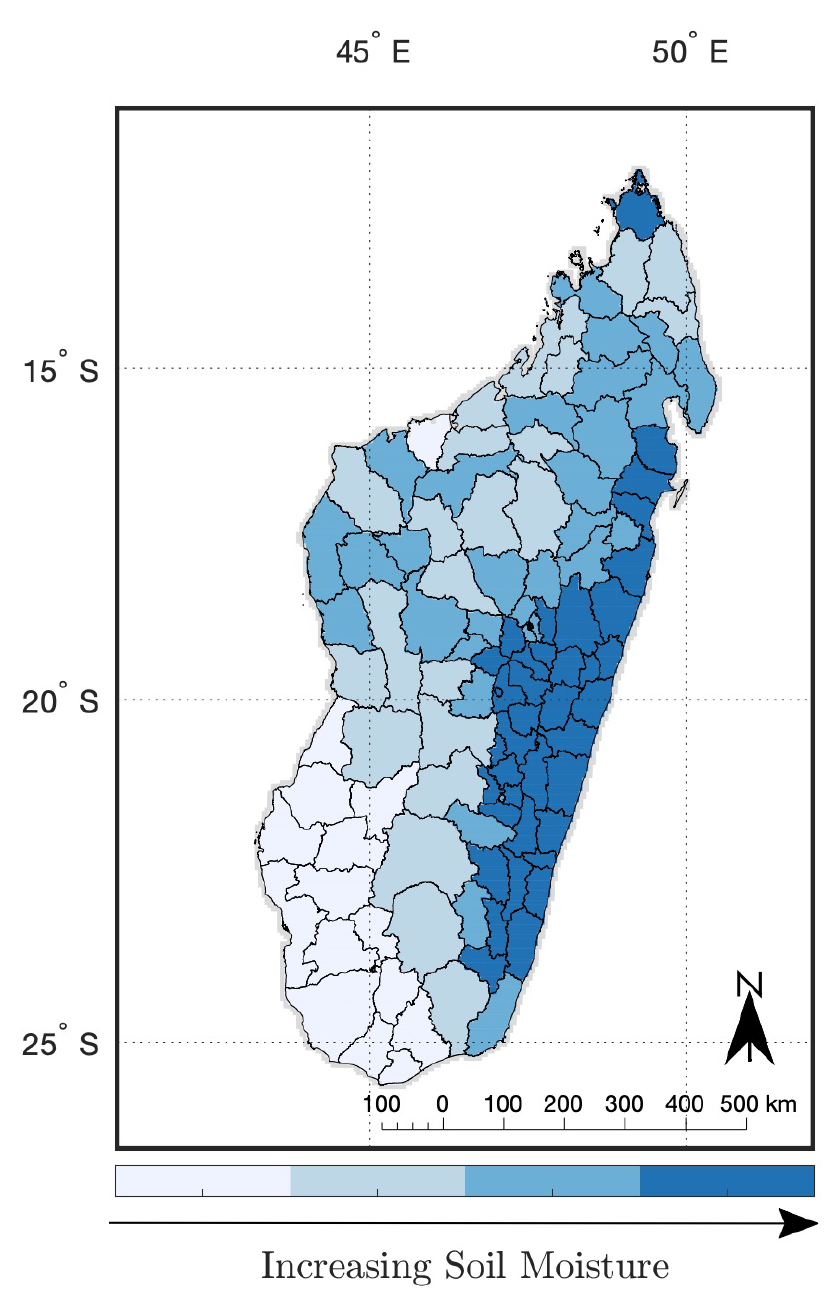
Figure 4. Districts are grouped into four climate regions based on the average soil moisture within the district from 2010 to 2017. We refer to these regions from low to high soil moisture as “arid”, “semi-arid”, “semi-wet”, and